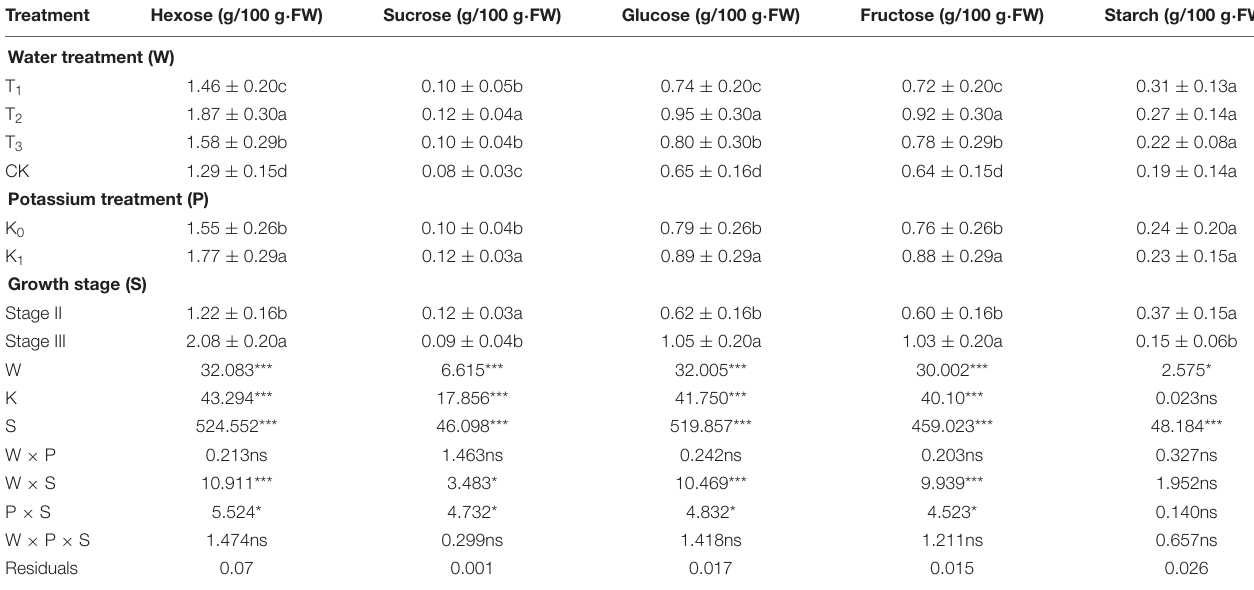
TABLE 4 | Three-way analysis of variance of fruits Hexose, Sucrose, Glucose, Fructose and Strach were performed to identify individual and interactive effects of water (4 levels: T 1 ,T 2 ,T 3 , and CK), potassium (2 levels: K 0 , K 1 ) and growth stage (2 levels: stage II and stage III) on the tomato fruits.